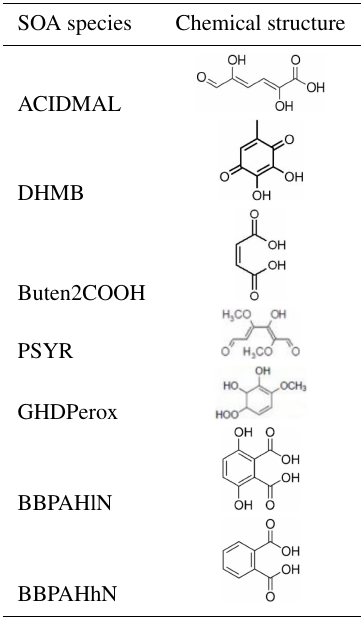
Table B2. Chemical structure of SOA compounds considered in this